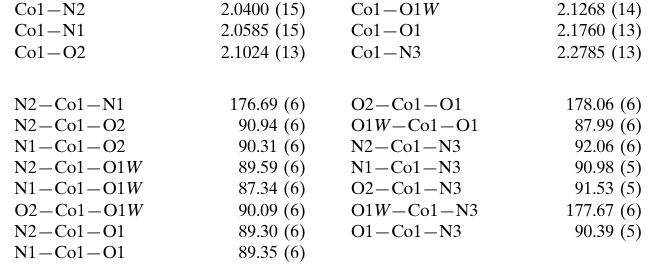
Selected geometric parameters (A˚ , (cid:4) ).